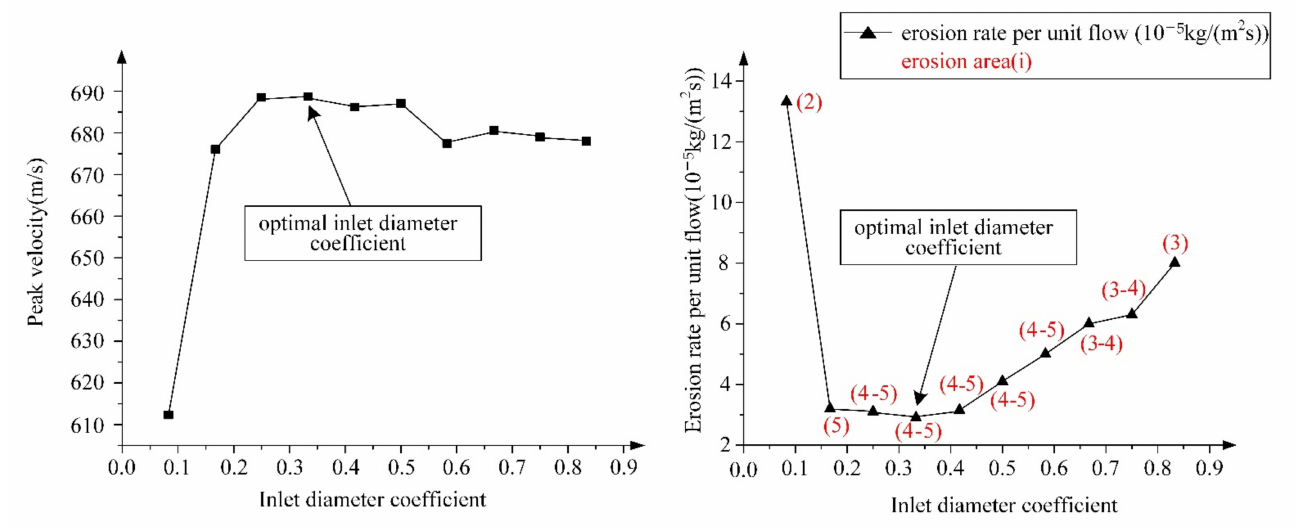
Figure 8. Effect of the inlet diameter coefficient on nozzle